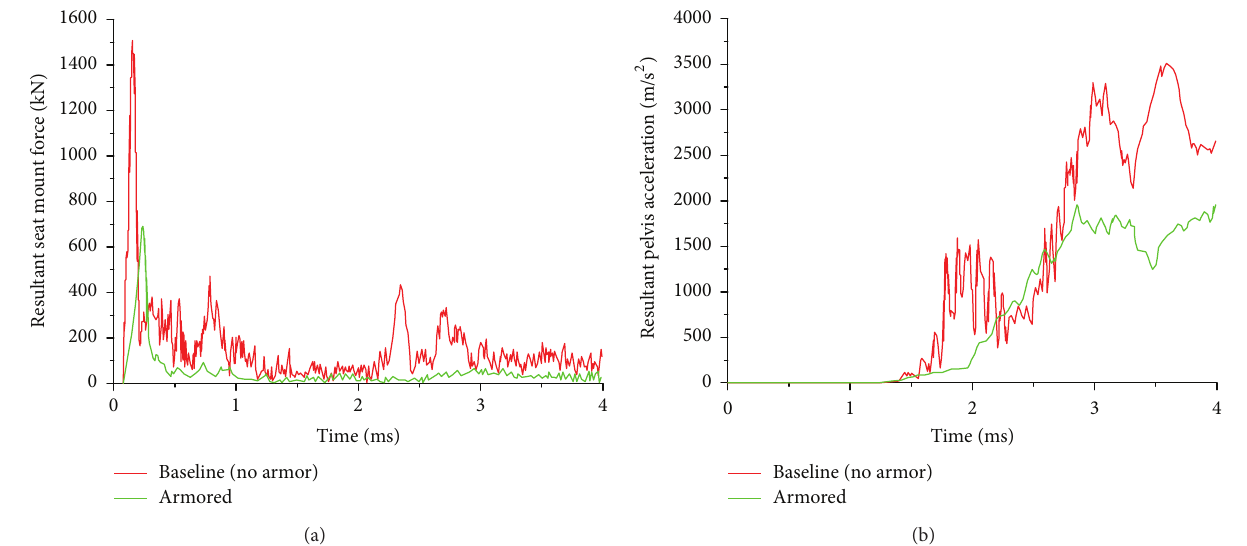
Figure 6: Comparison of blast-resistant capabilities of various designs with 2 kg TNT equivalent. (a) Seat mounts forces. (b) Crew pelvis acceleration.